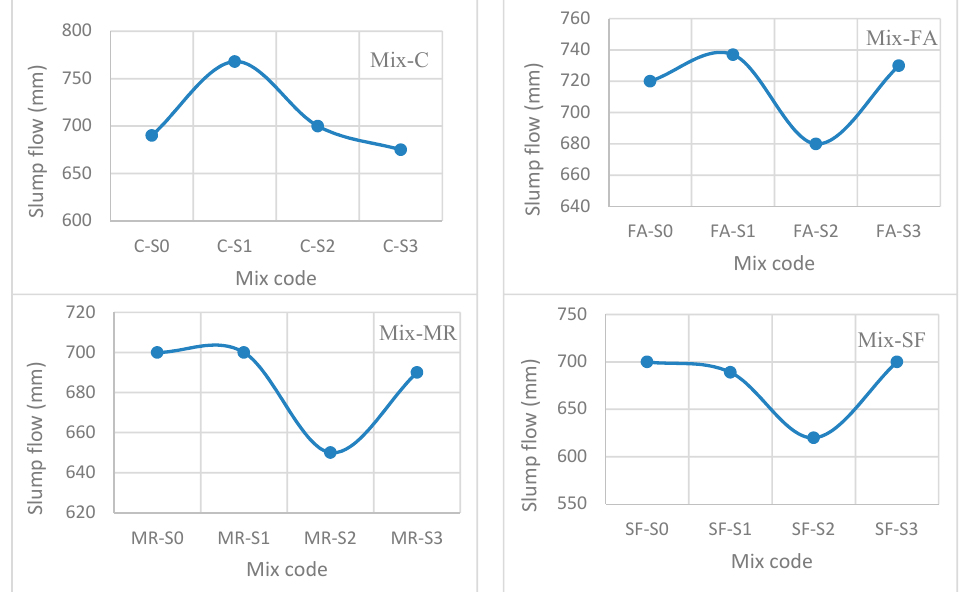
Figure 2. Slump flow results of all steel fiber reinforcement-self-compacting concrete (SFR-SCC) groups.